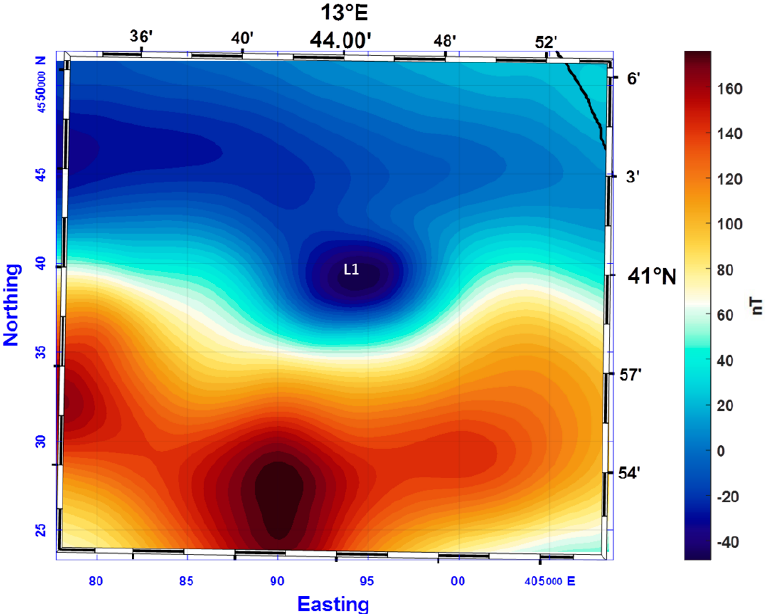
Figure 9. Total field aeromagnetic anomalies of the Gaeta Gulf at an elevation of 1463 m above sea level. Letters identify magnetic anomalies described in the text. The black line in the northeast corner of the map represents the coastline.